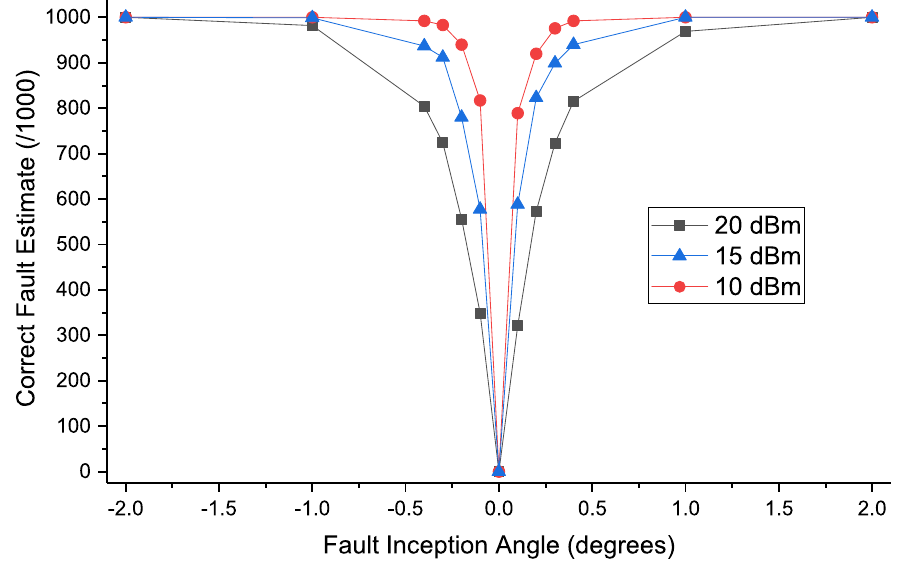
Figure 15. Correct fault estimates (out of 1000 simulation runs) at difference fault inception angles and noise levels. These tests were performed for a fault location of f p = 140 on the IEEE 13-bus network with R f = 10 Ω and under the conditions described in Sections 7.1 and